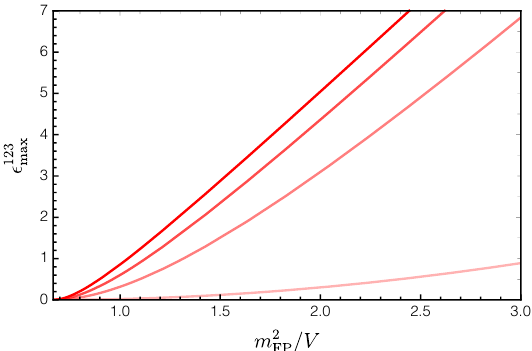
=V for the (cid:12) 1 (cid:12) 2 (cid:12) 3 -model for di(cid:11)erent FP